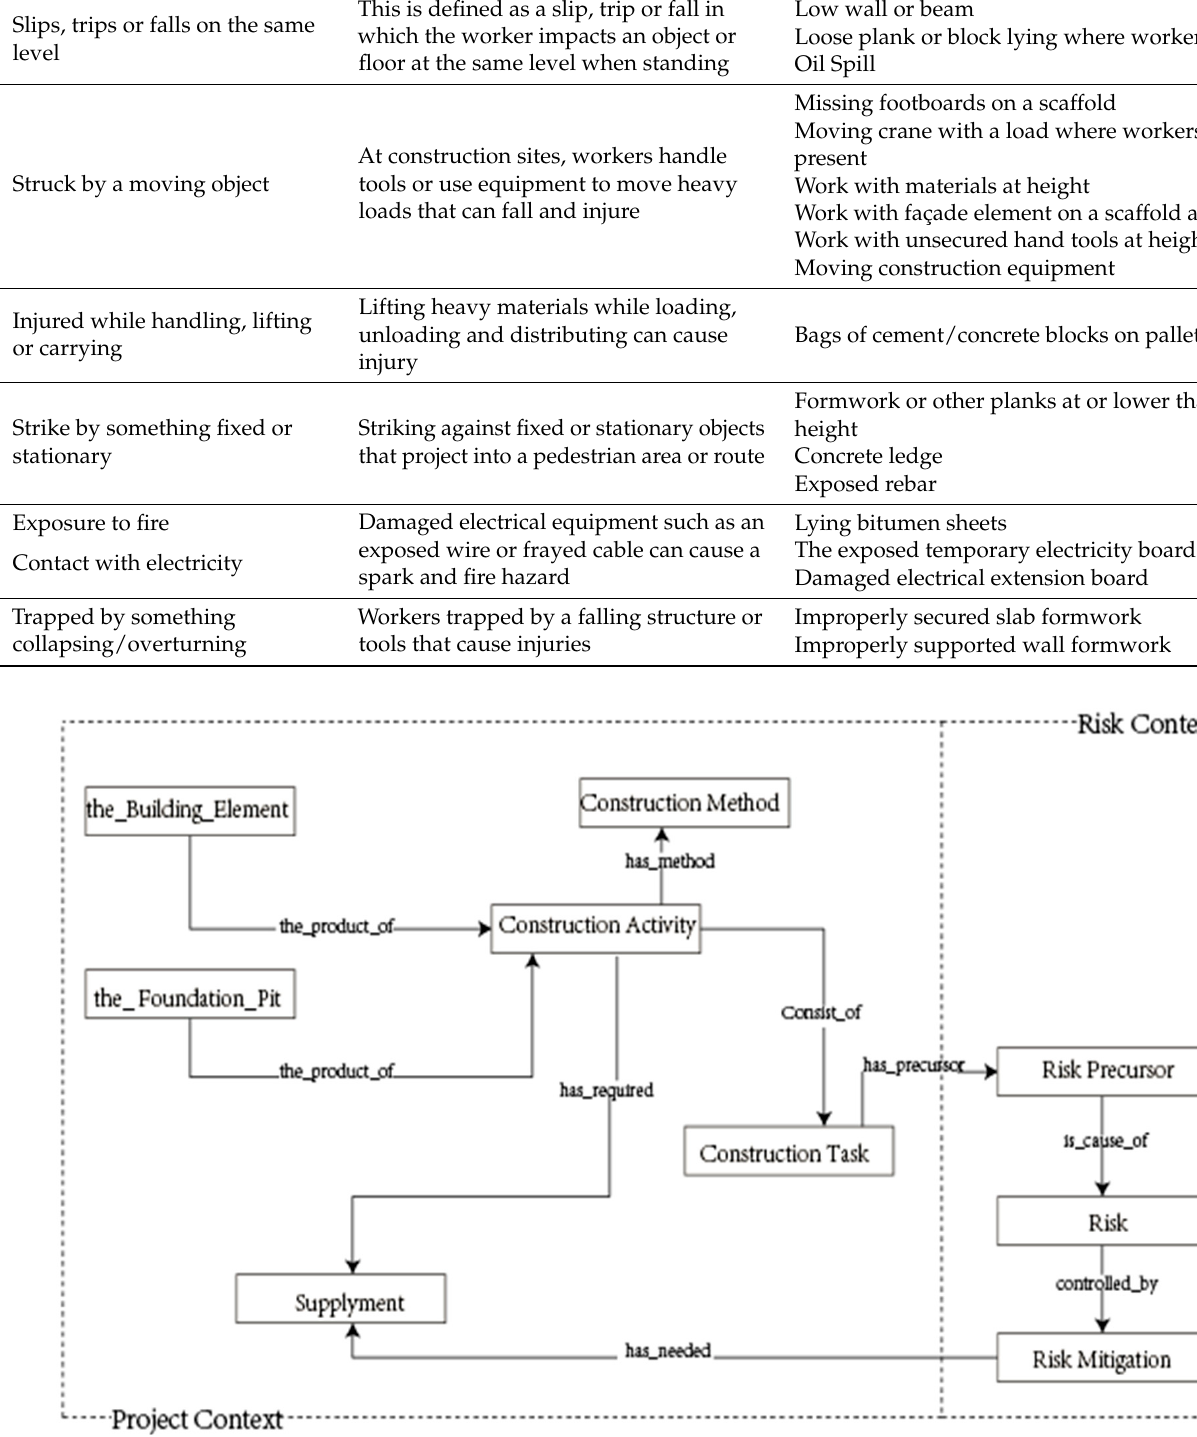
Figure 1. the construction health and safety meta ontology model. Figure 1. The construction health and safety meta ontology